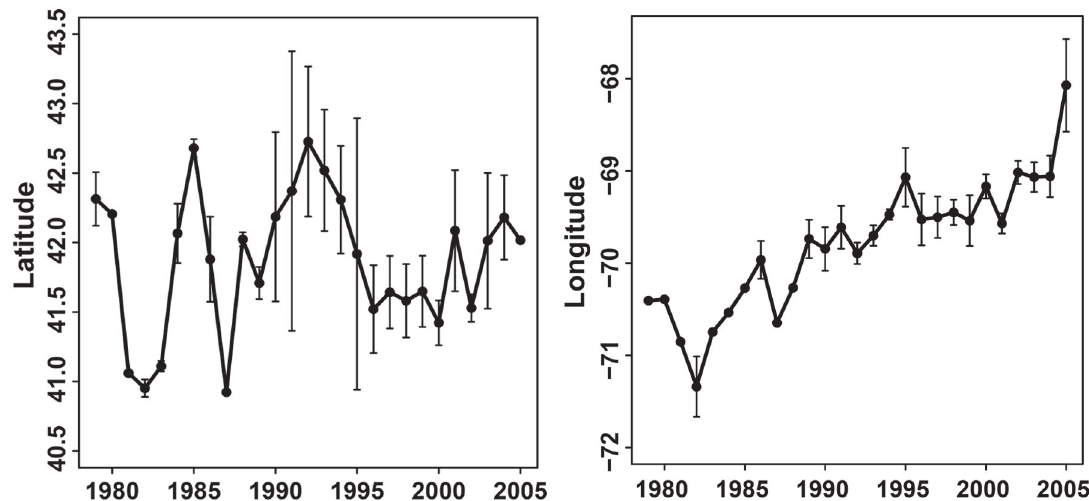
Figure 1. Surface school positions of Atlantic bluefin tuna in the Gulf of Maine. Each location represents the mean position of bluefin schools observed by spotter pilots, from vessels or represents captured fish from the commercial fishery. Within each year, mean positions were weighted by the number of fish in each school. Error bars represent sample variance. Schools of Atlantic bluefin tuna have shifted their longitudinal distribution approximately 280km to the east (70.95 to 68.47° W). doi: